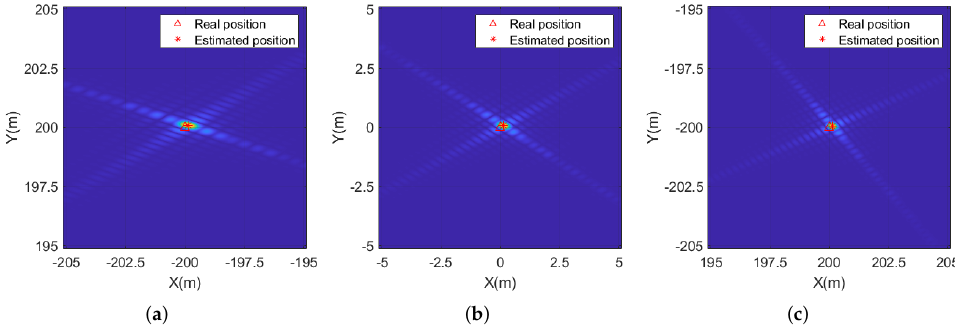
Figure 10. Scatter position estimation results: ( a ) point A; ( b ) point B; ( c ) point C.